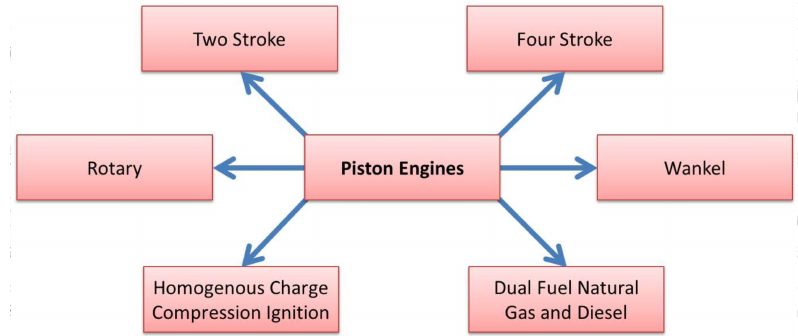
Figure 3. Classification of Piston Engine.